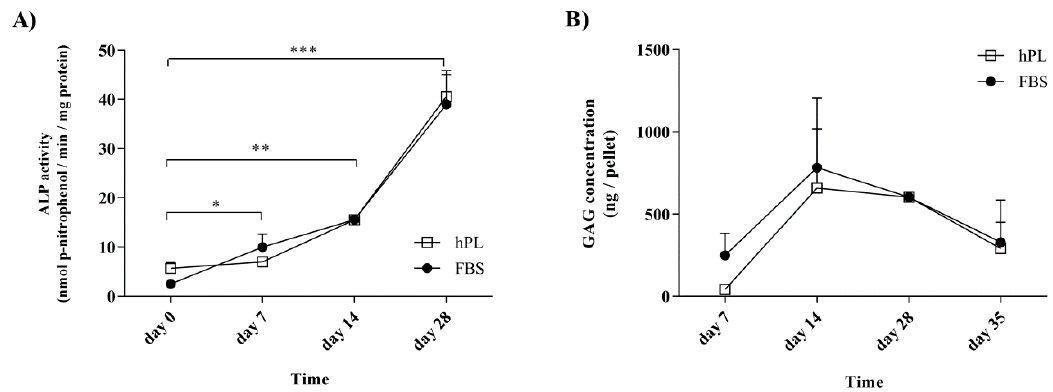
Figure 3. Lineage-specific bioactivity during osteogenic and chondrogenic di ff erentiation. ( A ) During osteogenic di ff erentiation, the alkaline phosphatase (ALP) activity significantly increased in a time-dependent manner over four weeks. ( B ) An initial increase was seen in GAG levels in chondrogenic cultures, with a subsequent decrease after two weeks of di ff erentiation as chondrogenesis advanced. (* p ≤ 0.05; ** p ≤ 0.01; *** p ≤ 0.001).